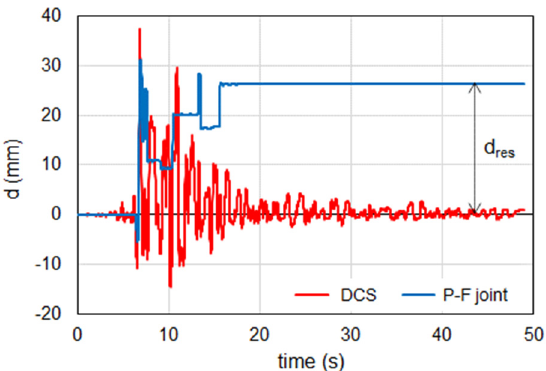
Figure 14. Displacement histories of the examined beam-to-column joints for record 196ya.